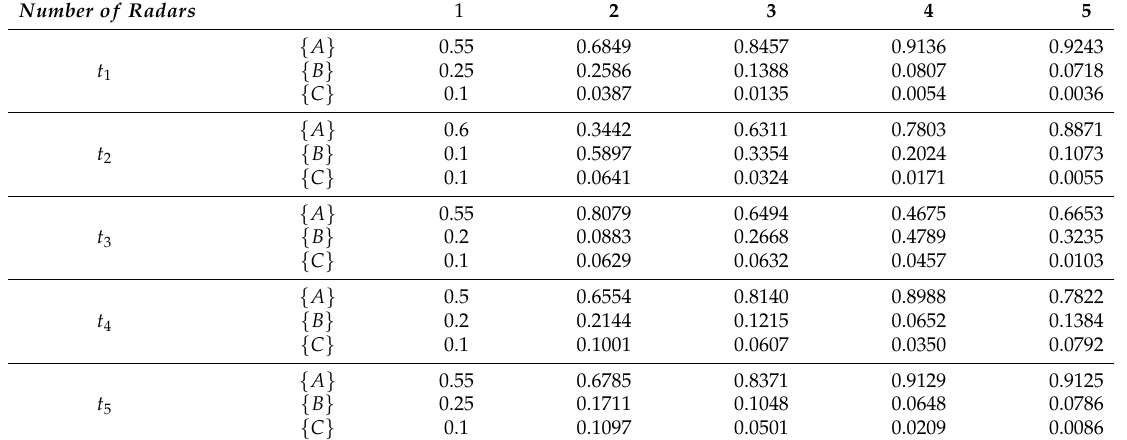
Table 7. Simulation results of the proposed method when the number of radars changes.